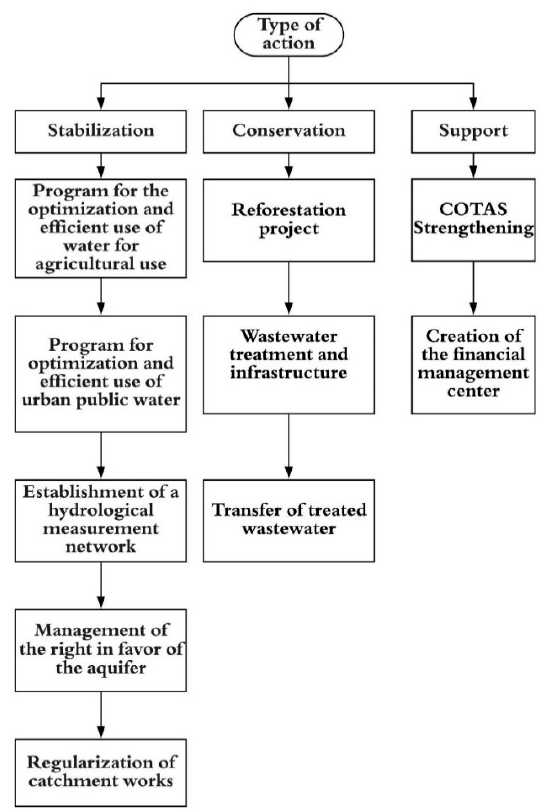
Figure 2. Actions proposed in the 2007 groundwater management plan for the Guadalupe Valley aquifer.